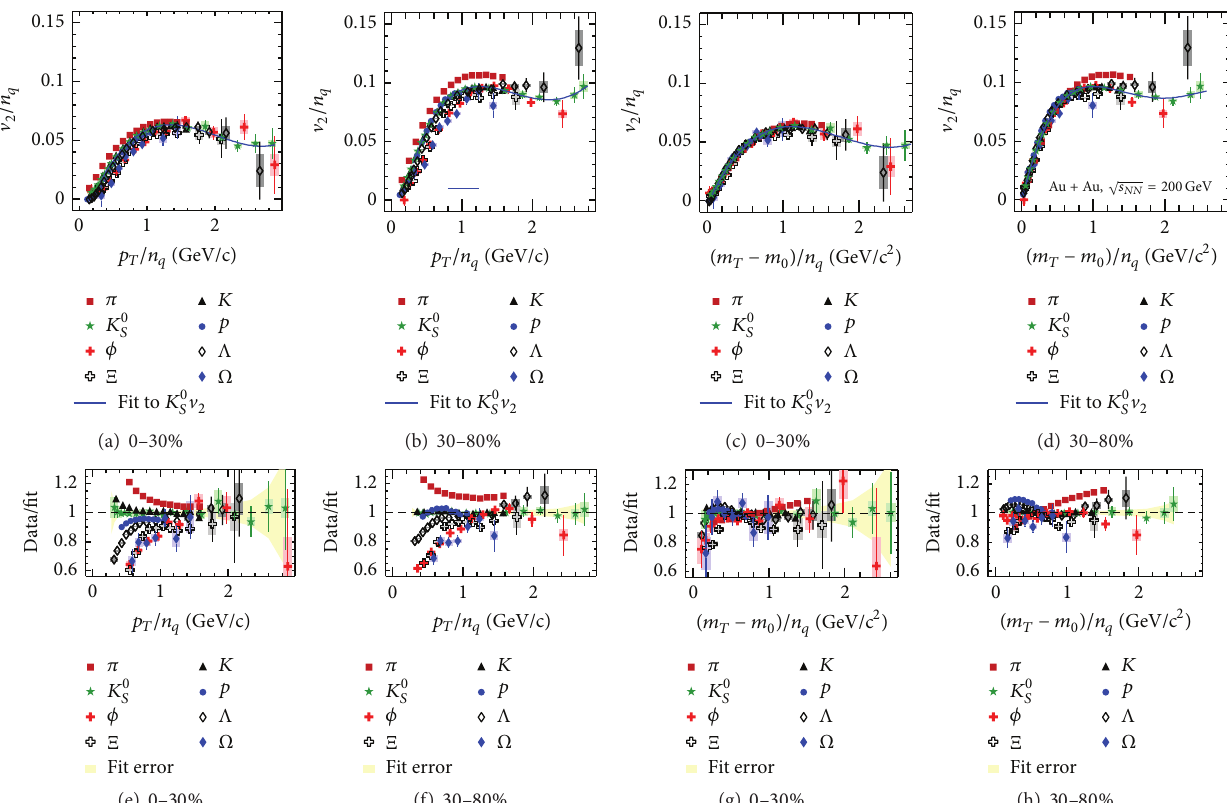
Figure 4: V 2 scaled by number of constituent quarks ( 𝑛 𝑞 ) as a function of 𝑝 𝑇 /𝑛 𝑞 and (𝑚 𝑇 − 𝑚 0 )/𝑛 𝑞 for identified hadrons from Au + Au collisions at √𝑠 𝑁𝑁 = 200 GeV for two centralities, 0–30% and 30–80%. Ratios with respect to a polynomial fit to 𝐾 0 𝑆 V 2 are shown in the corresponding panels (e–h)